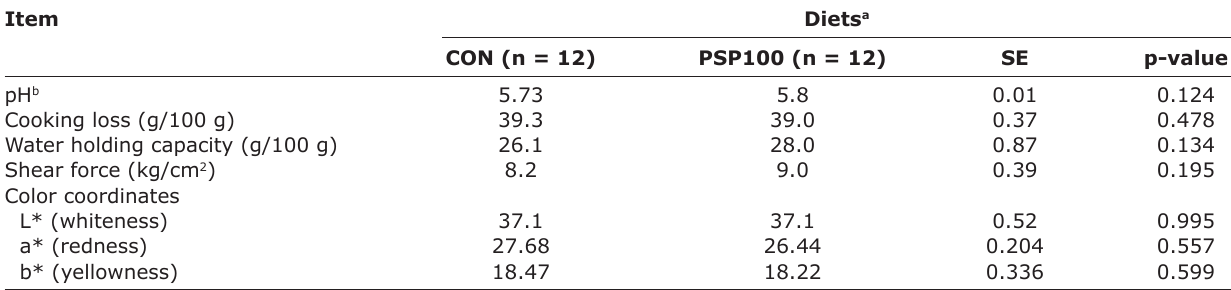
Table-5: Effects of feeding PSP on meat quality characteristics of Awassi lambs. Item